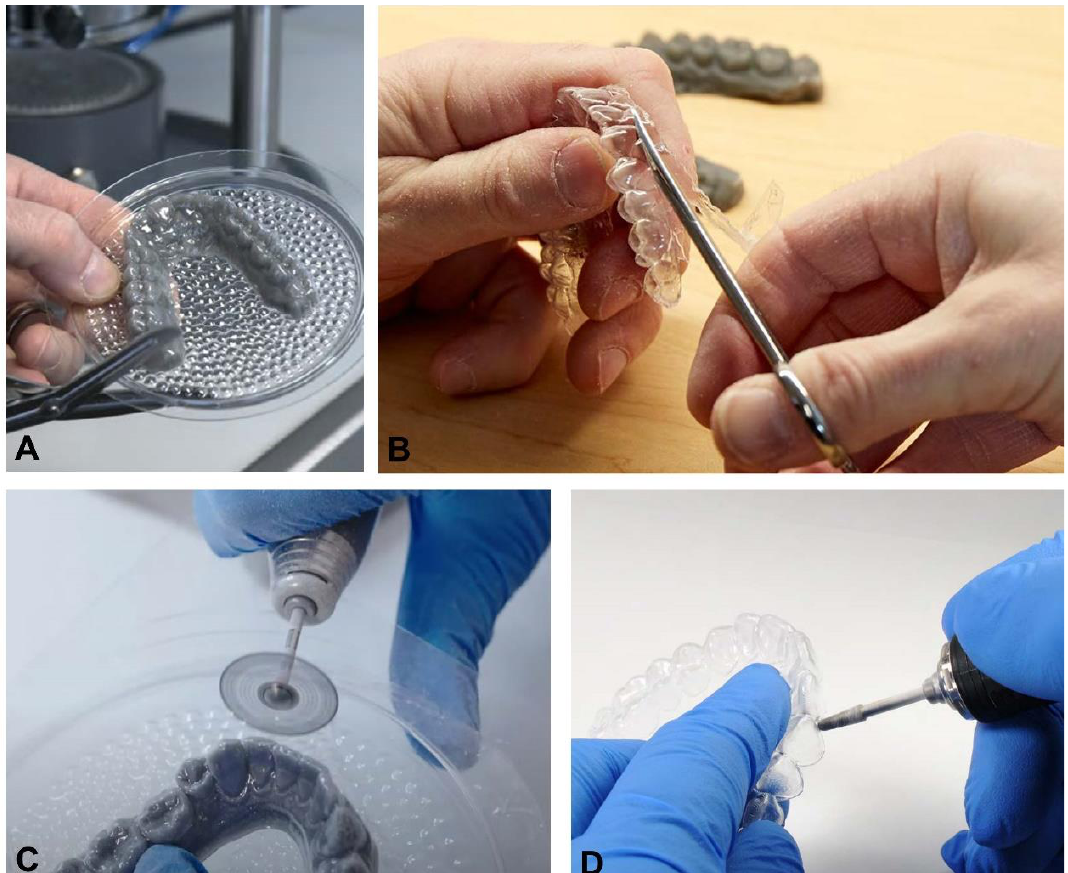
Figure 20. Aligner construction. ( A – C ), Aligner definition; ( D ), aligner refinement.